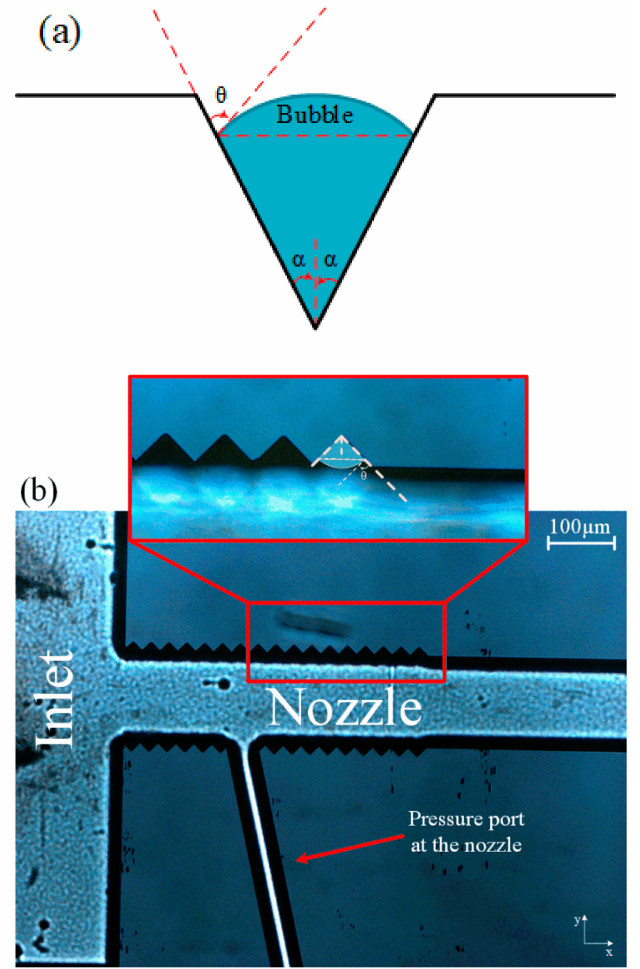
Figure 3. ( a ) Wall roughness elements and bubble ( b ) optical microscopy image of the wall roughness element inside the